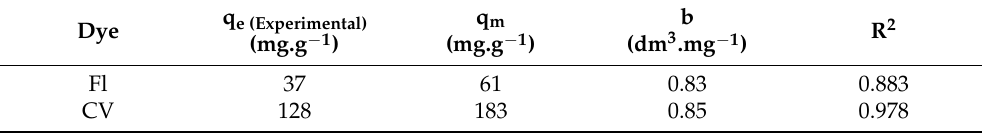
Figure 8. Langmuir and Freundlich isotherm model nonlinear fitting at 298 K: ( A ) adsorption isotherms of Fl, and ( B ) adsorption isotherms of CV. Table 3. Parameters of nonlinear Langmuir isotherm model for the adsorption process at 298